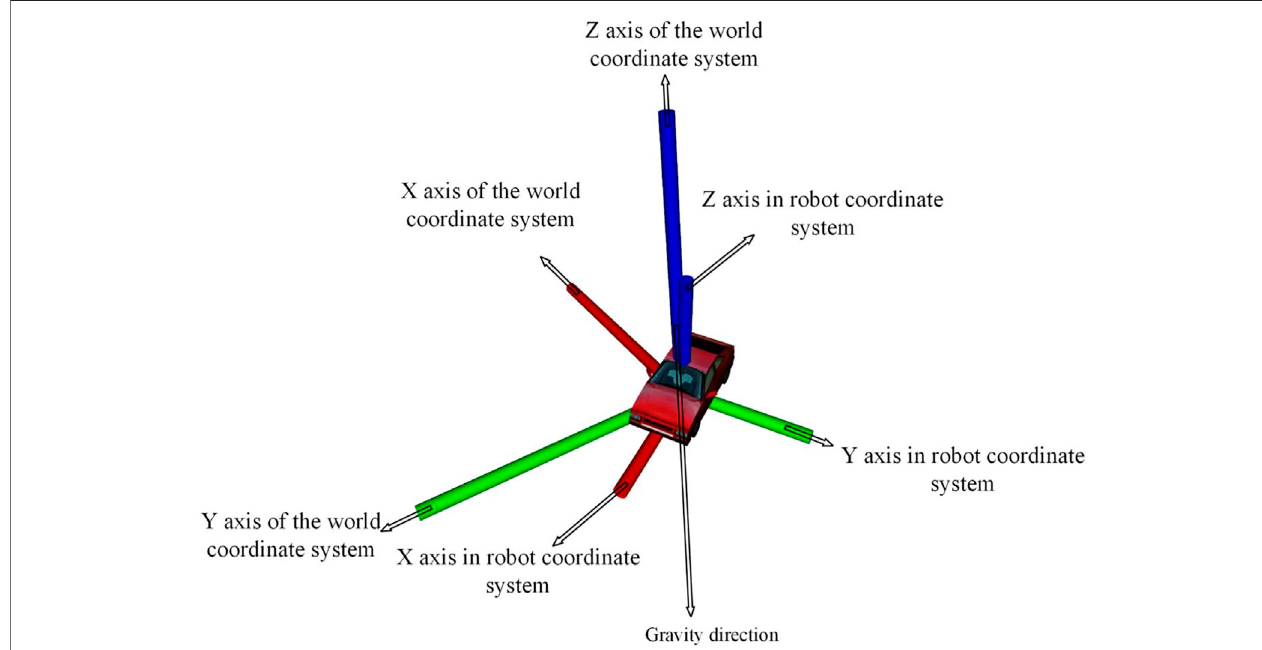
FIGURE 5 | Schematic diagram of robot and world coordinate systems.